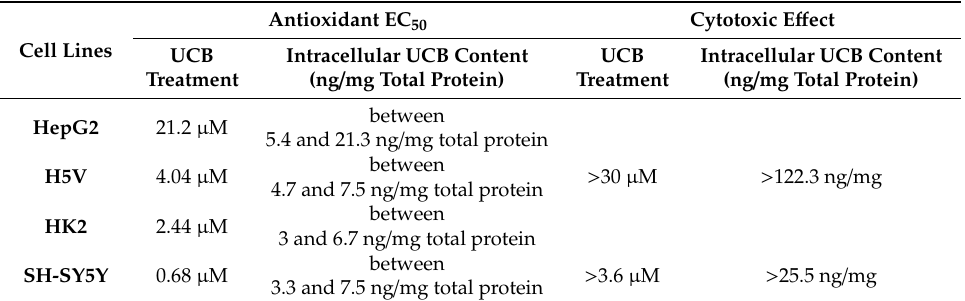
Table 2. The intracellular UCB concentrations corresponding to antioxidant (50% e ffi cacy concentration (EC 50 )) or cytotoxic e ff